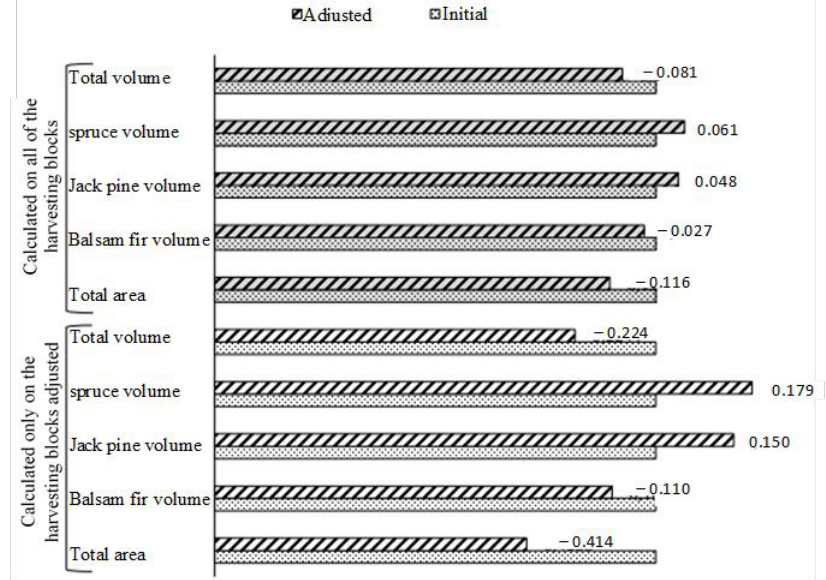
Figure 7. Variation between real-time inventory and initial inventory